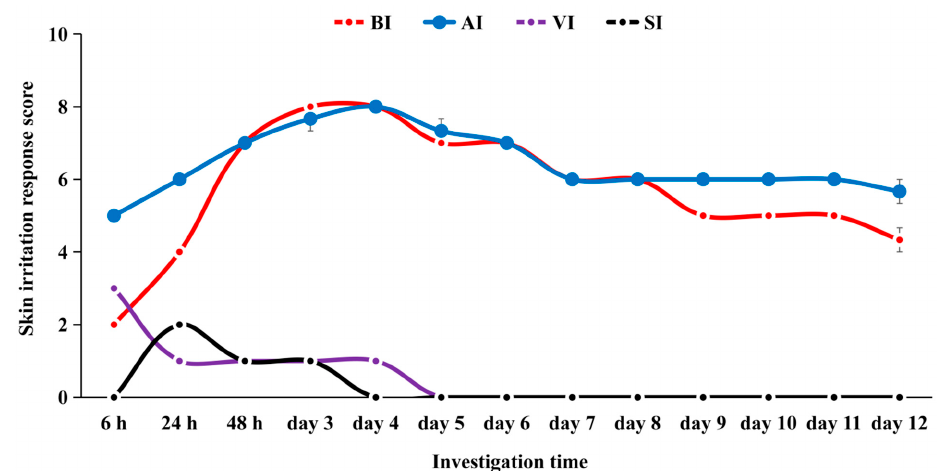
Figure 4. Skin irritation response scores of guinea pigs to intradermal injection treatments at differ- ent time points. The four treatment groups were as follows: (1) BI: S. invicta stings and bites; (2) AI: Intradermal injection of alkaloids; (3) VI: Vehicle control injection; and (4) SI: Injection of normal saline. On the 4th and 8th days in the AI and BI groups, epidermal cell necrosis at the site of skin tissue injury, nuclear shrinkage, fragmentation, dissolution, and bilateral spinous layer thickening were observed. The collagen fibers of the dermis and subcutaneous tis- sues and the myocytes of the hypodermis showed large areas of necrosis, accompanied by numerous lymphocytes and neutrophilic infiltration (Figure 5). On the 4th day in the AI and BI groups, compared with the 8th day, small areas of collagen fibers were reduced at the injury site, and the arrangement was sparse and irregular. The skin structures in the VI and SI groups were clear, and no obvious pathological changes were observed (Figure 5).